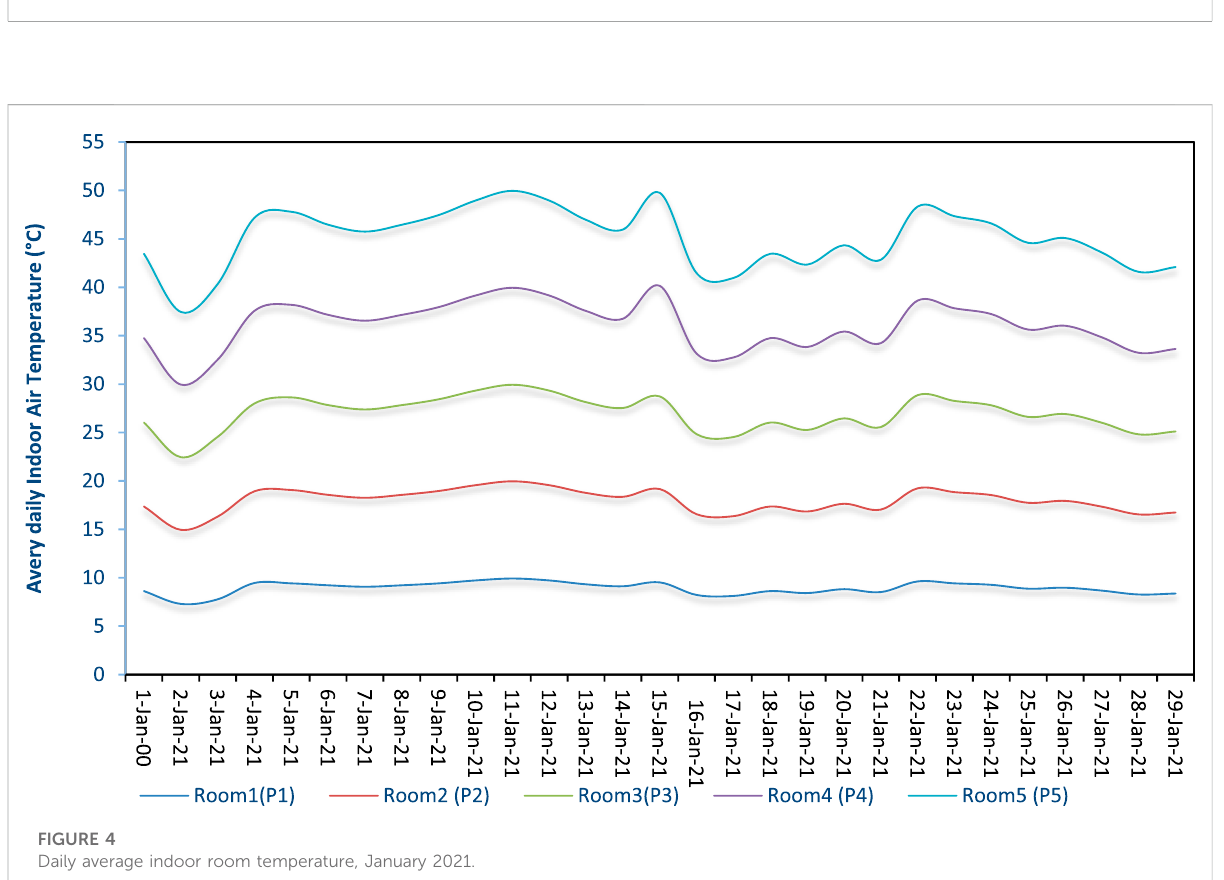
FIGURE 3 Graphical representation of thermal amplitude, time lag, and average daily indoor temperature (Ascione et al., 2013).